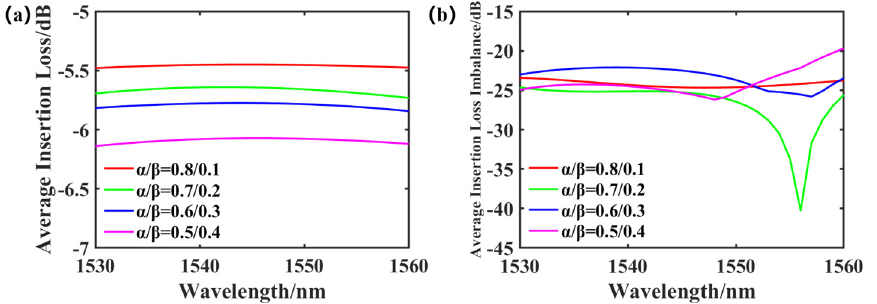
Figure 2. The effect of different weights changes on device performance. ( a ) The average insertion loss of the three output ports beneath different weights. ( b ) The average insertion loss imbalance of the three output ports beneath different weights. the three output ports beneath different